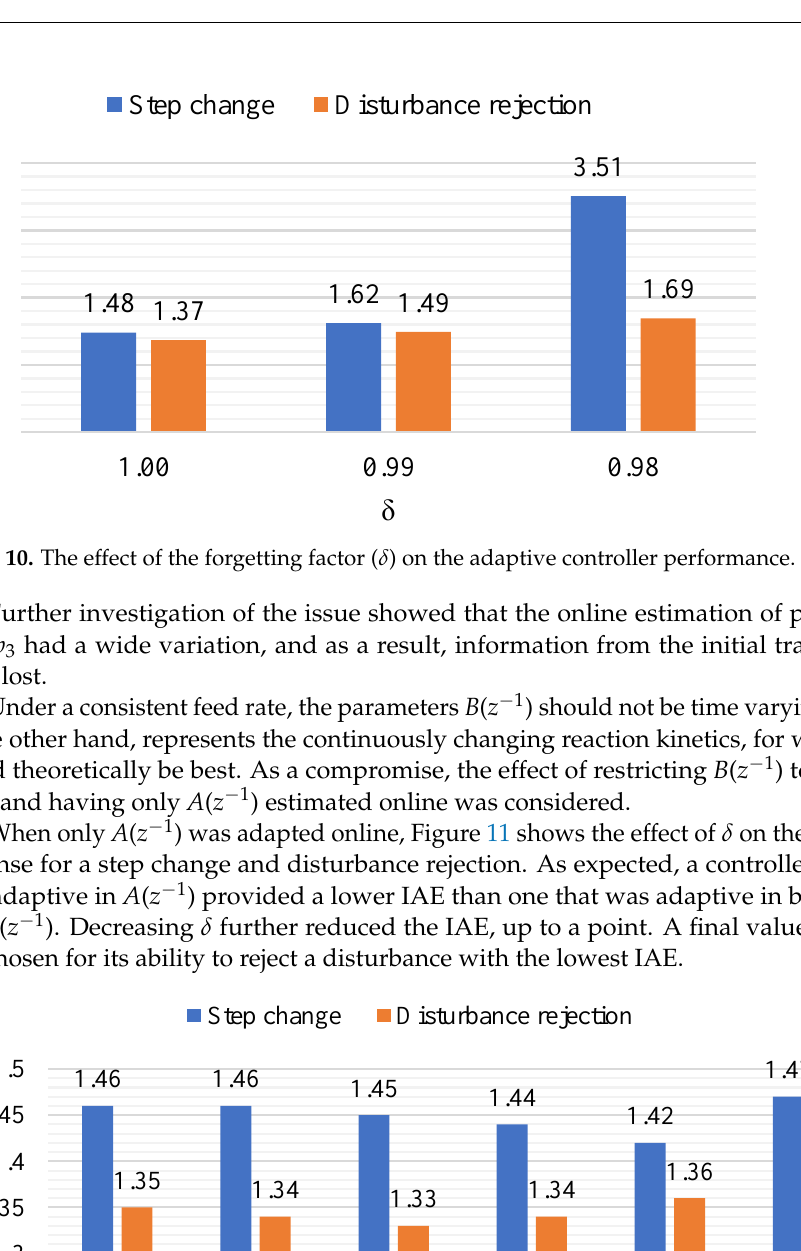
Figure 11. The effect of 𝛿 on the MPC performance that was adaptive only in A ( z −1 ). Although the step response would suggest a smaller value be used, the objective of